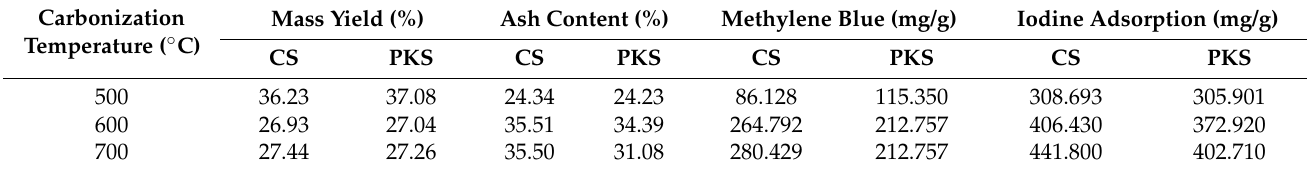
Table 1. Physiochemical properties of activated carbon without NaOH surface modification.